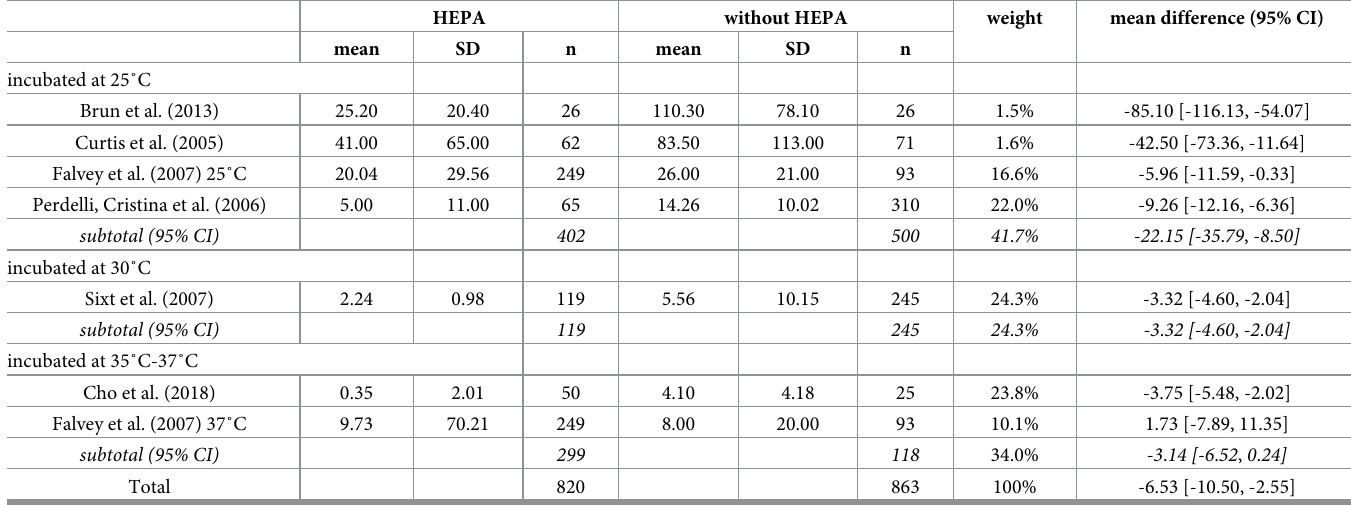
Table 9. Meta-analysis comparing the mean fungal colony forming units per cubic meter (CFU/m 3 ) in rooms with HEPA vs rooms without